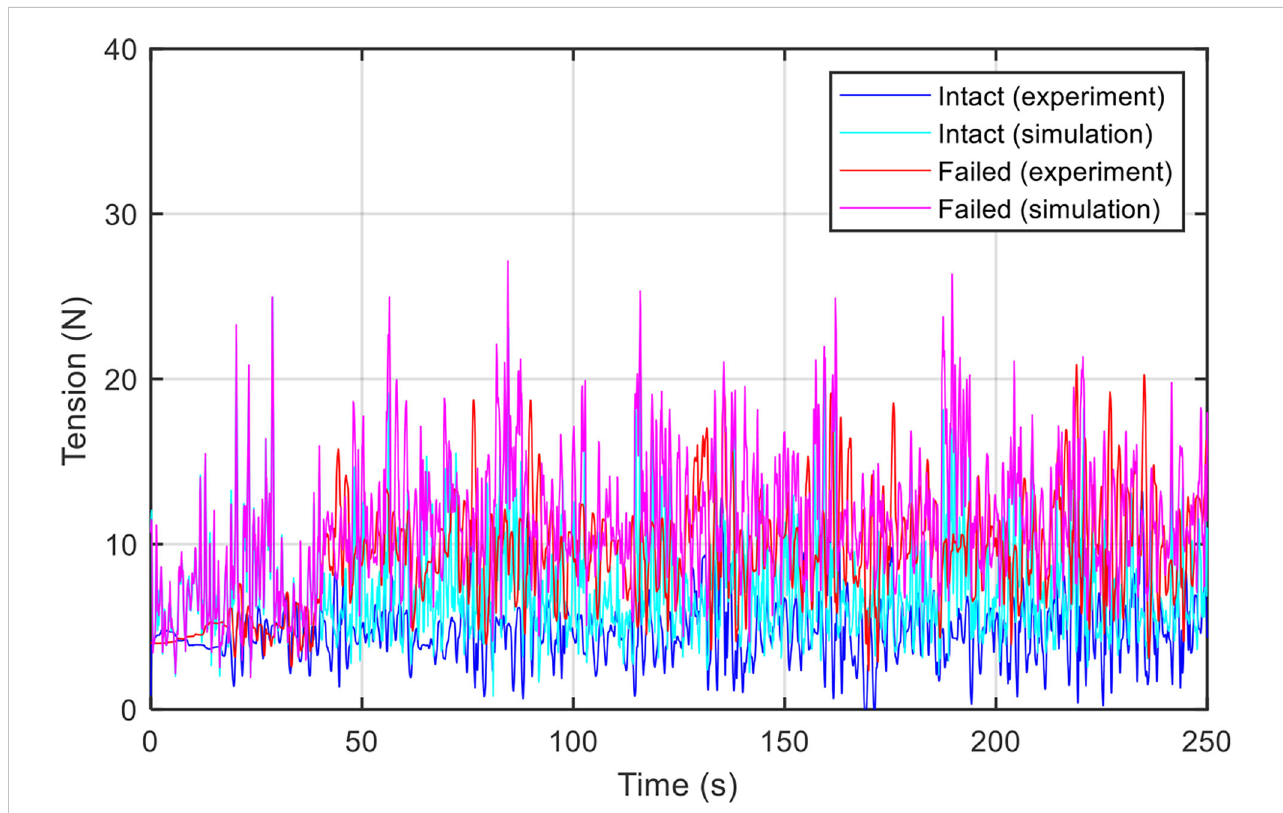
FIGURE 5 Time series tension responses of Line 2 under the intact and failed states of mooring.